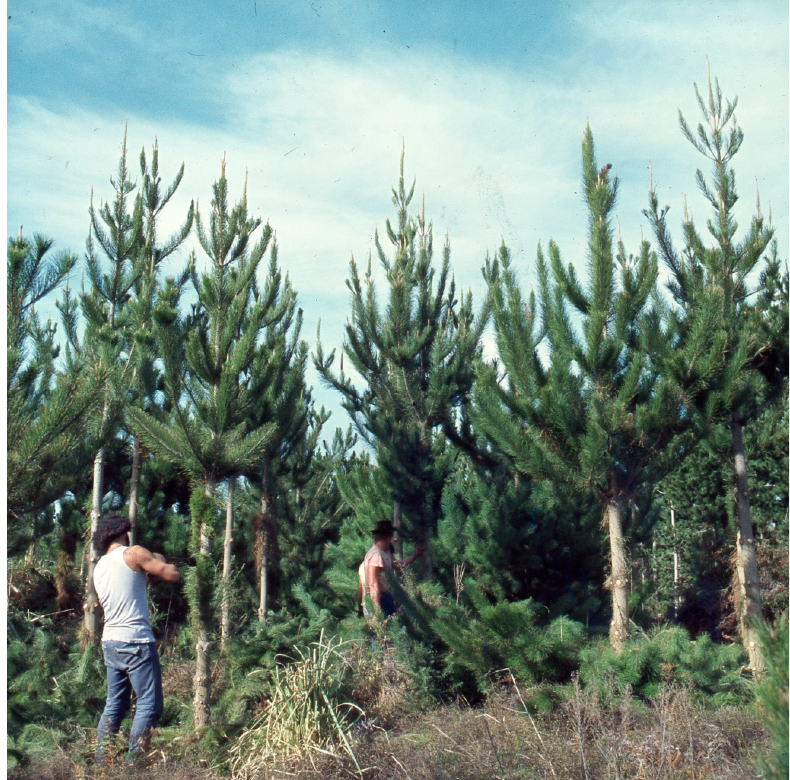
Figure 1. Young stand of P. radiata being pruned, showing general tree form (Scion Image Library). The species has a very restricted natural range. The full natural extent was barely 10,000 ha, which has been reduced to about 5000 ha by human activity. There are five discrete natural populations (Table 1). Three are on the Californian mainland, at latitudes 35 1 / 2 –37 ◦ N, and two are on Mexican islands Guadalupe at 29 ◦ N and Cedros at 28 ◦ N. All populations are located in a special, highly localised variant of the Mediterranean climate. It is characterised by cool sea fogs in summer coming off a cold ocean current to produce remarkably copious fog drip from tree crowns. The fog drip compensates for an almost complete lack of summer rainfall. Nowhere does the species occur naturally more than about 5 km from the sea. Although the native climates are almost never very closely matched elsewhere, the species thrives over large areas in other parts of the world, mostly in the Southern Hemisphere with mild oceanic climates. It is now grown over an area of some 4 million ha, supporting major industries on a scale far out of proportion to that area. The two countries growing it on the largest scale are Chile and New Zealand, followed by Australia and then Spain. Indeed, it is generally the utility softwood of choice for planting wherever it thrives. Domesticated stocks of the species have evidently descended almost entirely from the two northernmost natural populations, Monterey (Lat. 36 1 / 2 ◦ N and Año Nuevo (Lat. 37 ◦ N), with a disproportionate ancestral contribution from the much smaller Año Nuevo population [34,36]. These domesticated stocks have been the subject of almost all the research on the